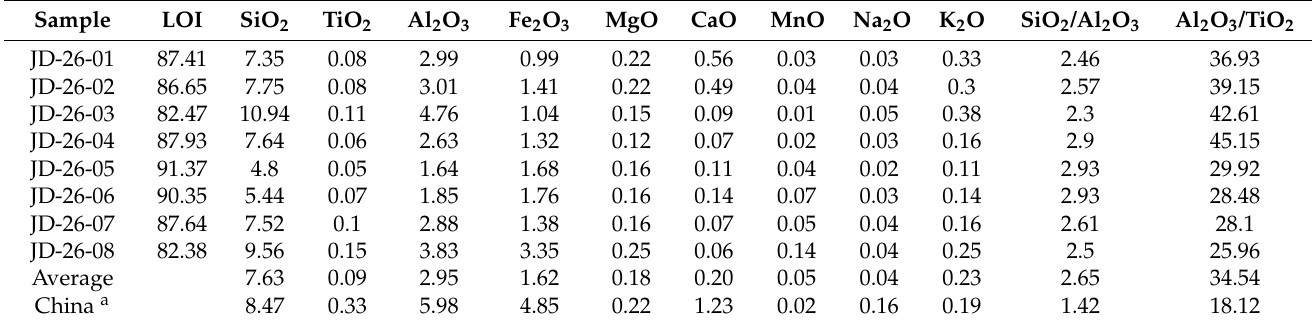
Table 3. The concentration of MEO in No. 26 coals, on a whole coal basis (%).